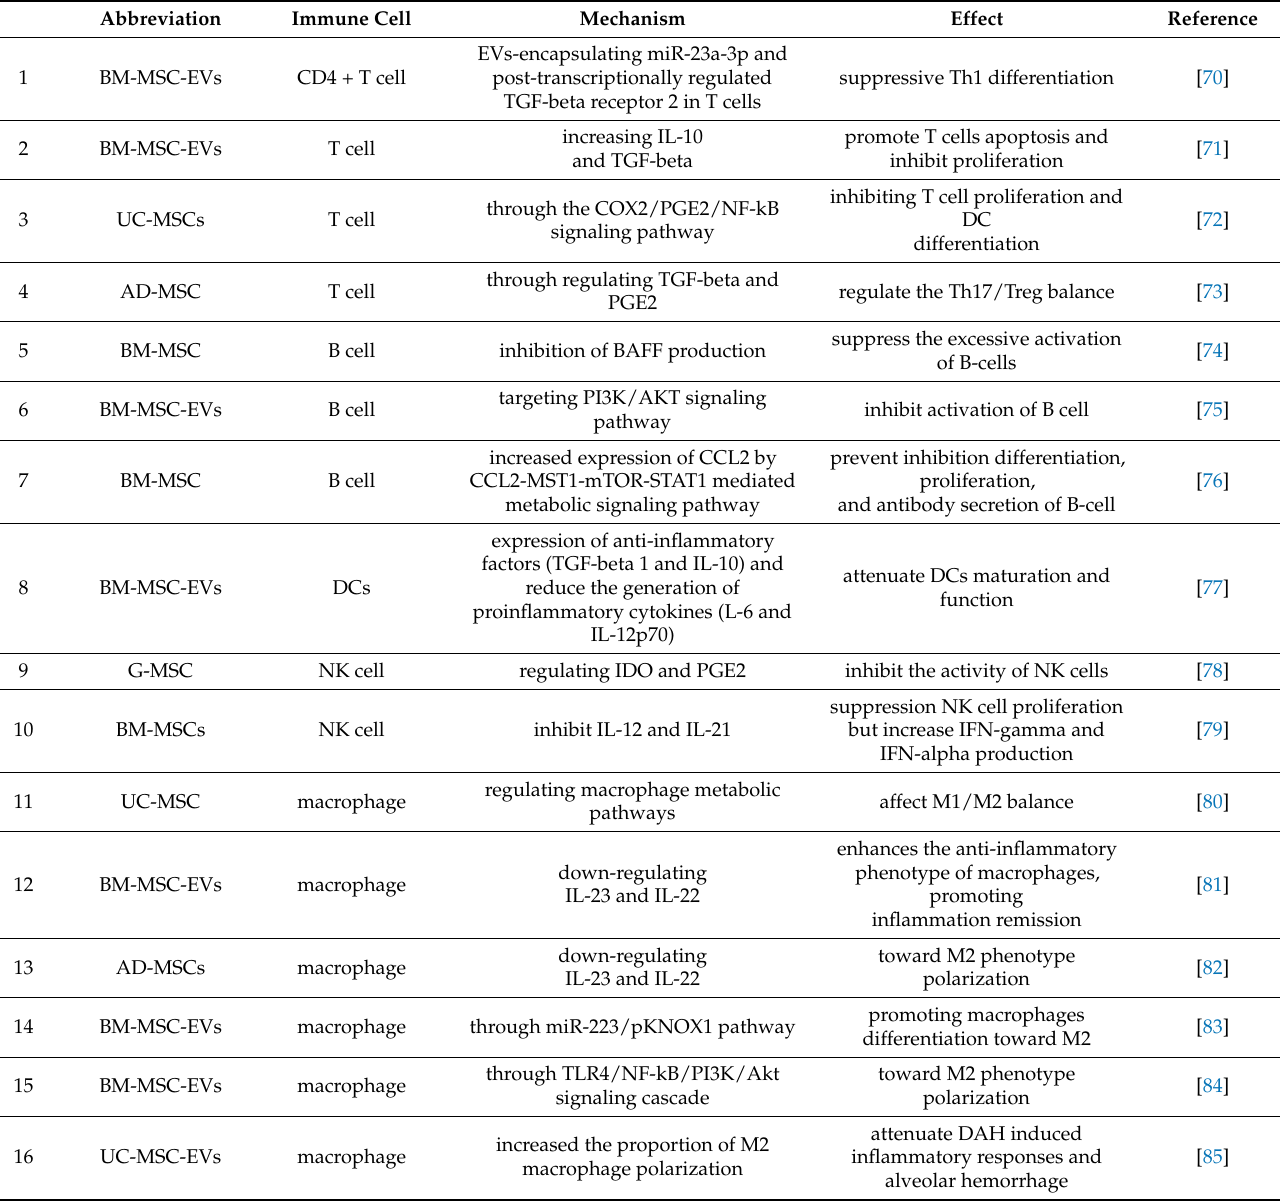
Table 2. Mechanisms of MSCs and MSC-EVs influence on immune